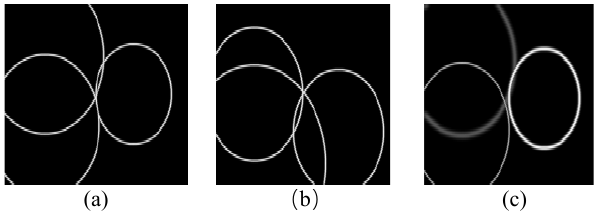
Figure 8 . Signal space score map generated by different tag positions for the same base station layout. (a) The horizontal coordinate of the label was 1.6m. (b) The horizontal coordinate of the label was 1.8m. (c) The horizontal coordinate of the label was 2.0m.